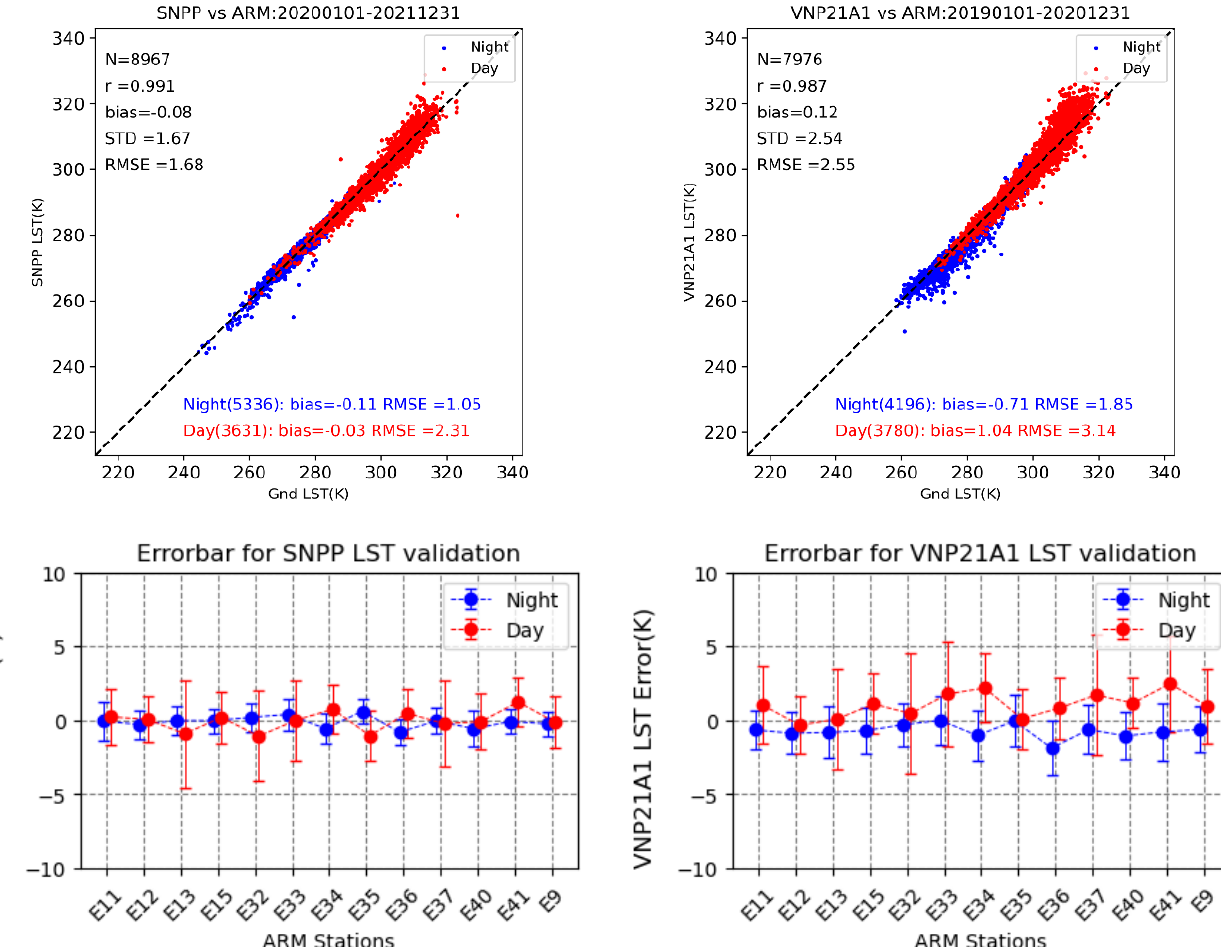
Figure 10. LST validation against ARM data for SNPP ( left ) and VNP21A1 ( right ) with the overall valuation result at top and site wide results at the bottom.